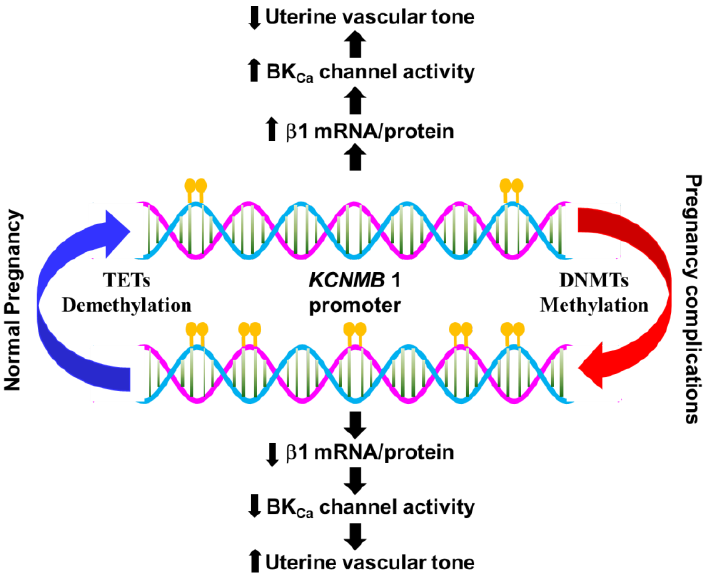
Figure 3. Epigenetic regulation of BK Ca channel β 1 subunit expression in uterine vasculature. The expression of the BK Ca channel β 1 subunit in uterine arteries of nonpregnant sheep is low due to hypermethylation of the KCNMB 1 promoter. Pregnancy increases the expression of the BK Ca channel β 1 subunit via promoting TET1-mediated demethylation of the promoter. Gestational hypoxia promotes methylation by upregulating DNMT3b and suppresses demethylation by downregulating TET1, leading to KCNMB 1 repression.